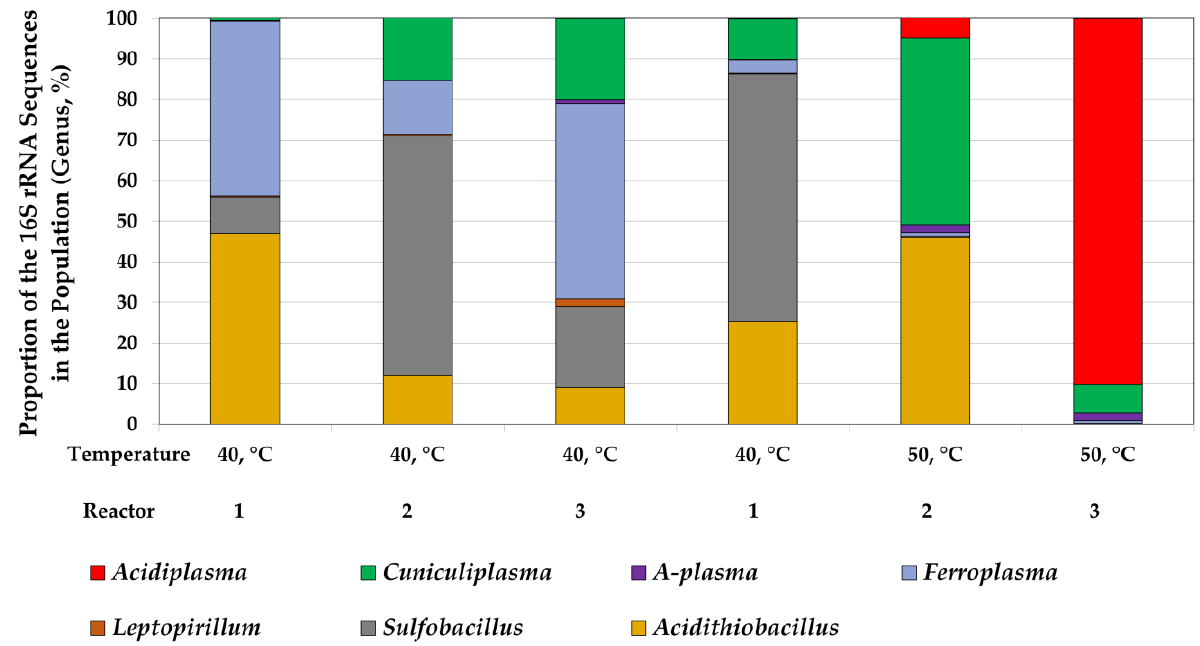
Figure 2. Analysis of microbial populations performing bioleaching under different conditions (proportion of the 16S rRNA gene fragment).